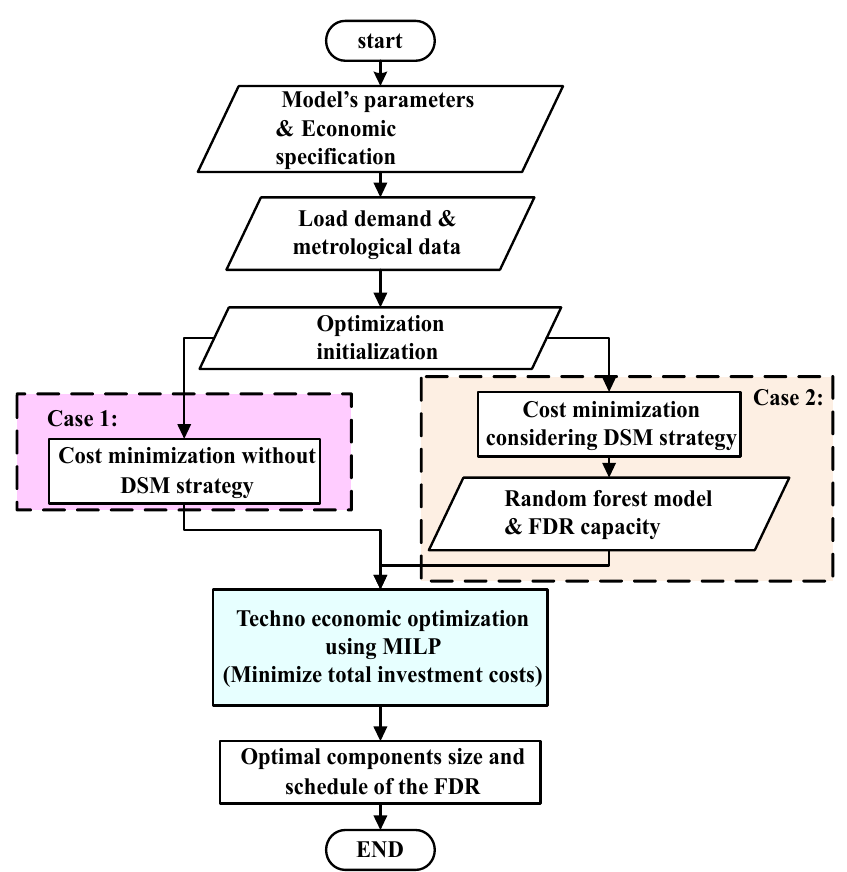
Figure 2. Proposed smart microgrid planning